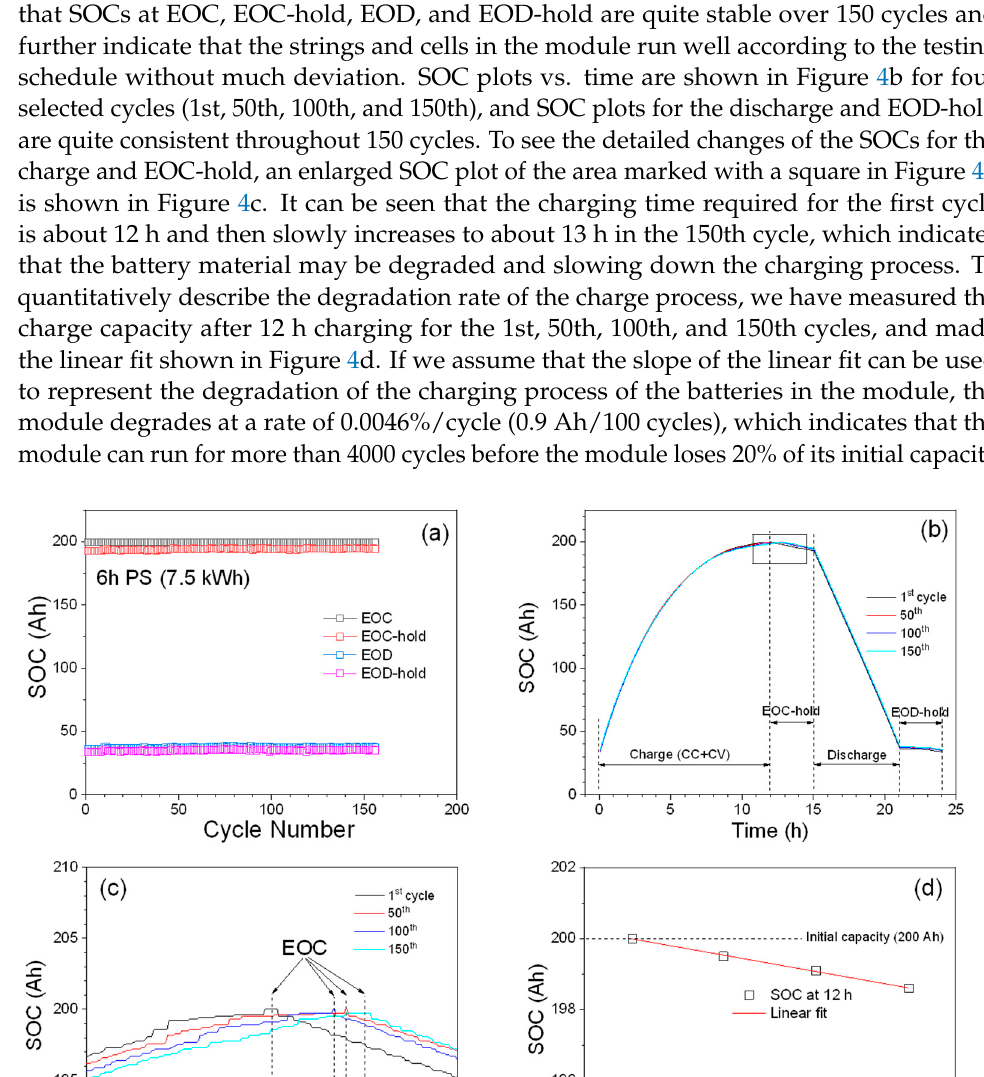
Figure 5. Initial heating-up and standby modes of the module. ( a ) Consumed energy and temperature of the heating-up process; ( b ) SOC and temperature of the module during the standby mode without getting power from external battery cycler.